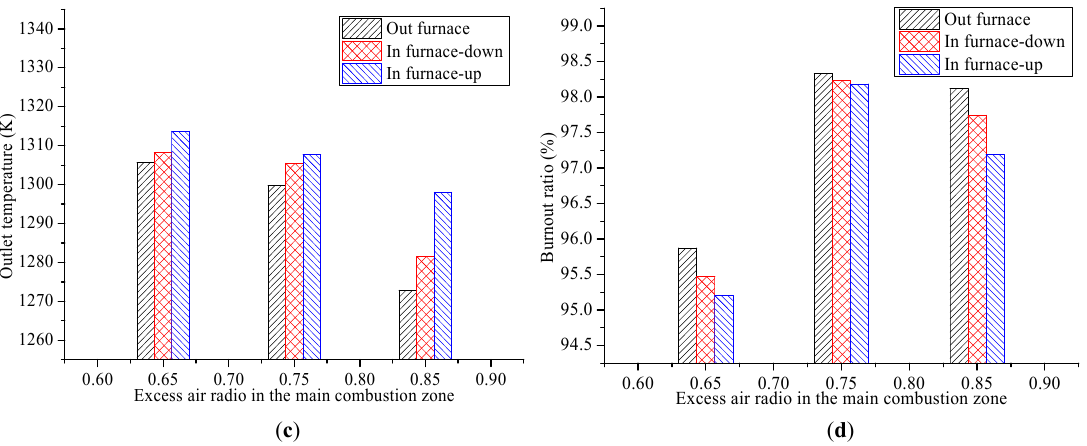
Figure 12. Some indicators at the furnace outlet under various α 1 ; ( a ) the NO x concentration; ( b ) the carbon content in fly ash; ( c ) The outlet temperature; ( d ) The burnout ratio